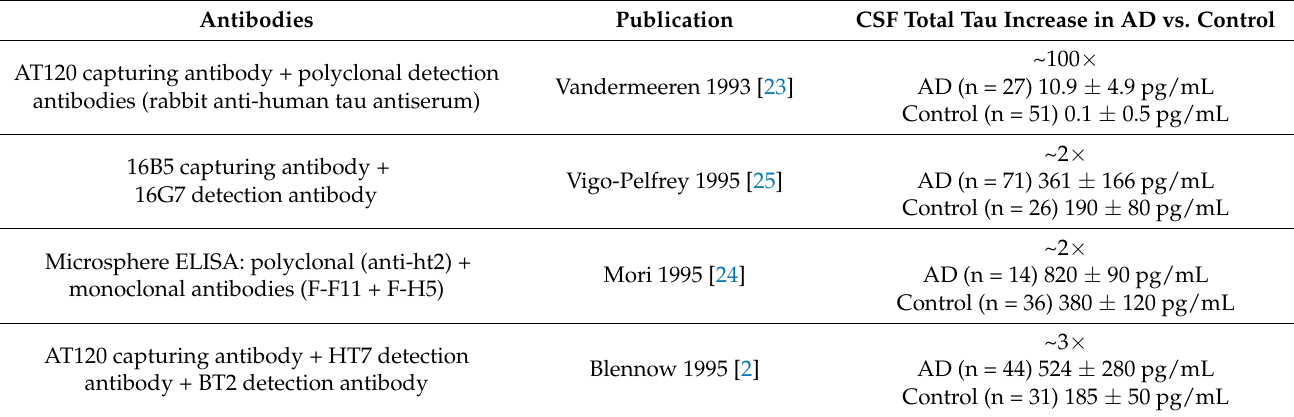
Table 1. ELISA techniques to measure CSF total tau. Antibodies Publication CSF Total Tau Increase in AD vs. Control AT120 capturing antibody + polyclonal